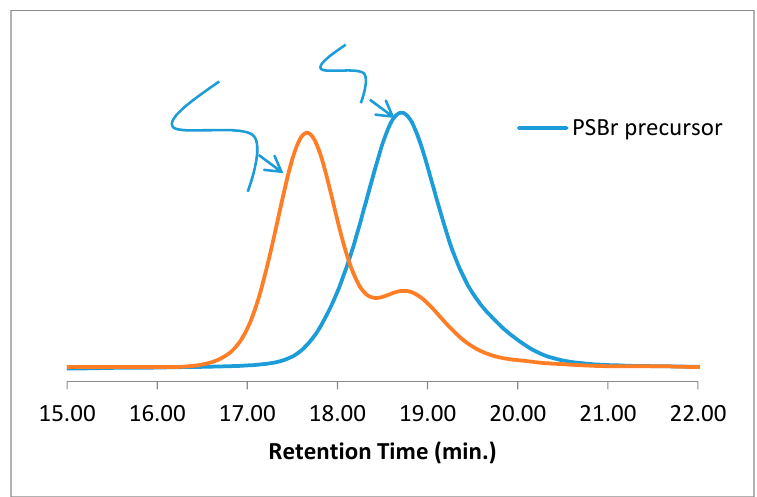
Figure 3. GPC traces of PSBr precursor (blue) and unpurified product of dimerization reaction (orange). Note that this is not a cyclization reaction, but a dimerization reaction performed at higher concentrations. RTA ‐ ATRC reaction was conducted at 60 °C and [PSBr] of 15 mM. Precursor characteristics: M n : 3800 Da, M p : 4600 Da, Đ : 1.2. Coupled product characteristics: M n : 6400 Da, M p : 9600 Da, Đ : 1.31.